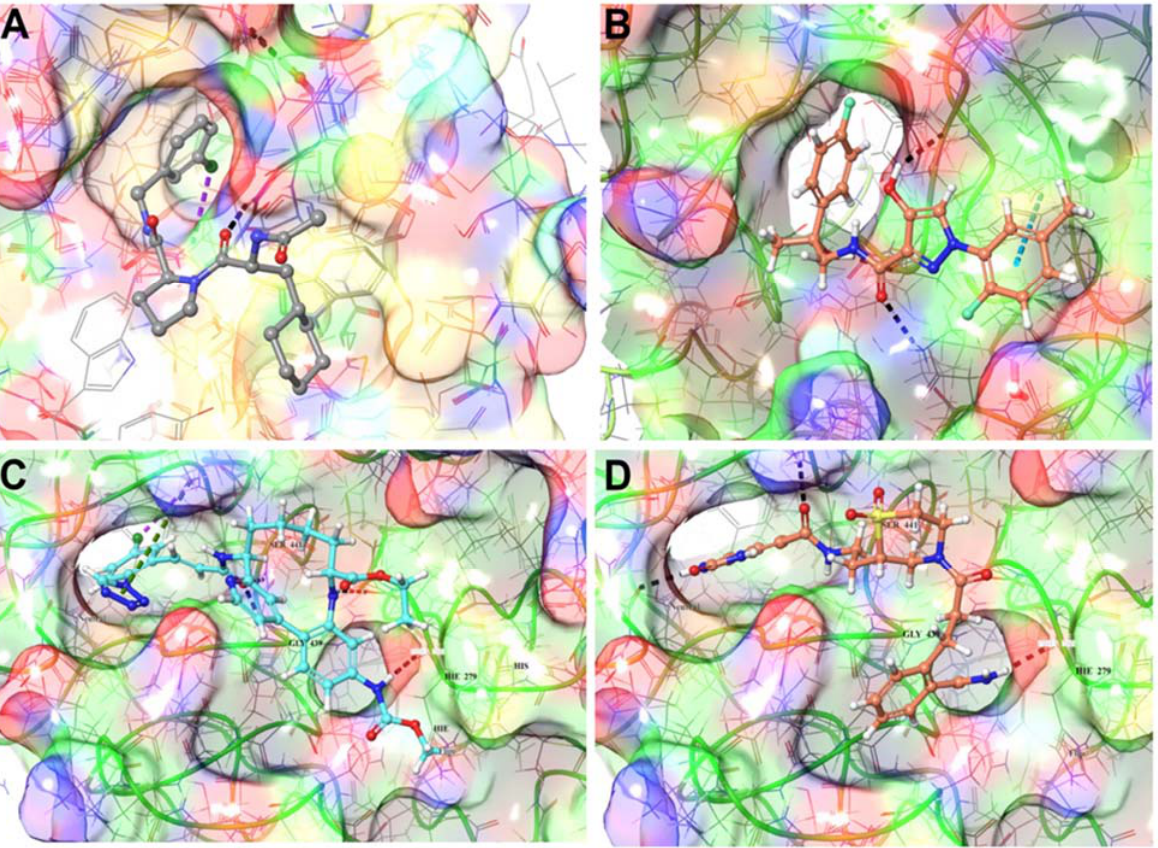
Figure 5. Modelled catalytically active form of TMPRSS2 bound to inhibitors. ( A ) Homology model of TMPRSS2 based on crystal structure of thrombin (3F68) is shown docked with 1 ‐ (2 ‐ fluoro ‐ 5 ‐ methylphenyl) ‐ N ‐ [2 ‐ (4 ‐ fluorophenyl) ‐ 2 ‐ hydroxy ‐ propyl] ‐ 4 ‐ hydroxy ‐ 1H ‐ pyrazole ‐ 3 ‐ carboxamide ( B ). A proposed macrocycle ‐ bound structure ( C ) and docked N ‐ (2 ‐ 4 ‐ [3 ‐ (2 ‐ Carbamoylphenyl)propanoyl] ‐ 1,1 ‐ dioxido ‐ 2 ‐ thiomorpholinyl}ethyl) ‐ 2 ‐ oxo ‐ 2,3 ‐ dihydro ‐ 1H ‐ benzimidazole ‐ 4 ‐ carbox ‐ amide ( D ) as further exemplars for inhibition of Tmprss2.